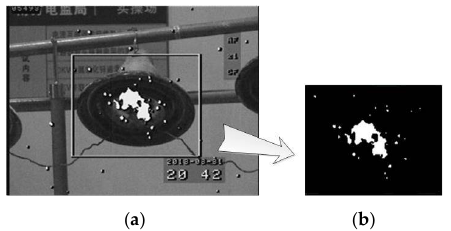
Figure 6. Extraction of the discharge spot: ( a ) grayscale image and ( b ) binary image.